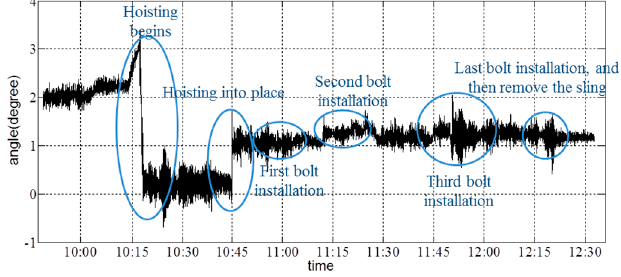
Figure 18. Angle about the x -axis of the girder during hoisting.